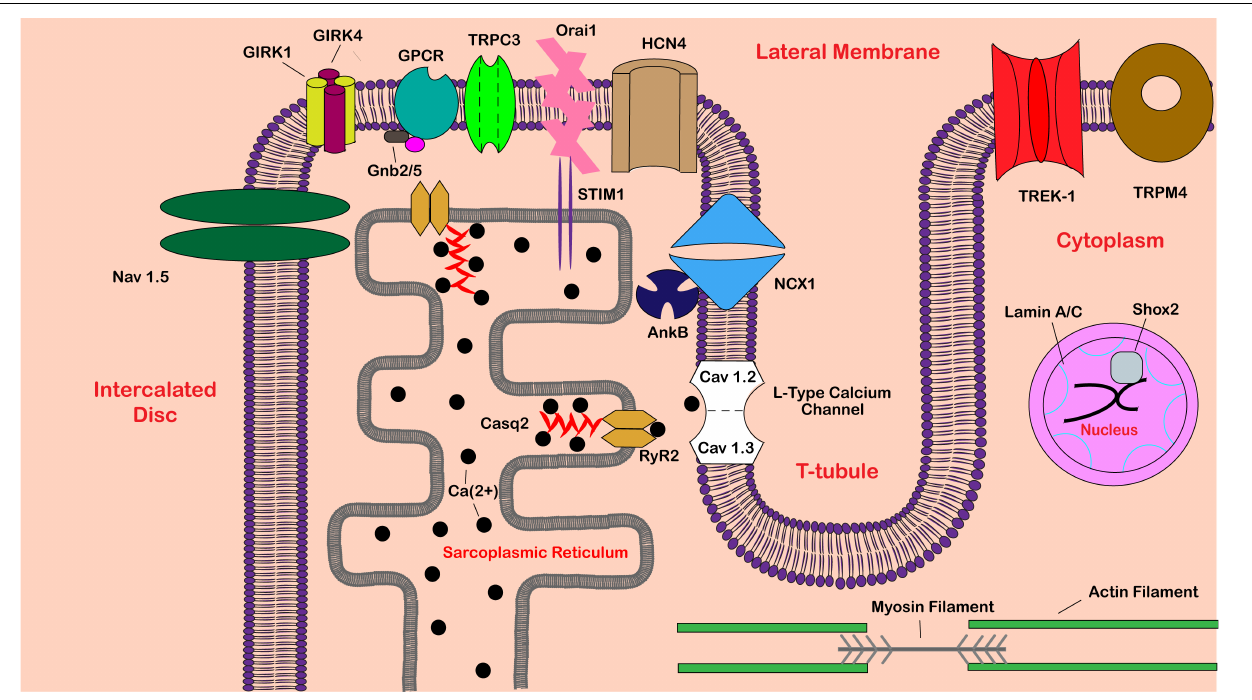
FIGURE 1 | Schematic of proteins implicated in sinoatrial node dysfunction. Shown is a partial sinoatrial (SA) pacemaker cell. Proteins are labeled in black text, while various cellular locations are labeled in red text. Abbreviations include calsequestrin-2 (Casq2), ryanodine receptor 2 (RyR2), G protein-activated inward rectifier potassium channel 1/4 (GIRK1/4), guanine nucleotide-binding protein subunit beta-2/5 (Gnb2/5), G protein-coupled receptor (GPCR), sodium/calcium exchanger 1 (NCX1), voltage-gated sodium channel alpha subunit 5 (Na v 1.5), hyperpolarization activated cyclic nucleotide gated potassium channel 4 (HCN4), ankyrin-B (AnkB), short-stature homeobox 2 (Shox2), transient receptor potential cation channel subfamily C member 3 (TRPC3), stromal interaction molecule 1 (STIM1), calcium-release-activated calcium channel protein 1 (Orai1), potassium two pore domain channel subfamily K member 2 (TREK-1), and transient receptor potential melastatin 4